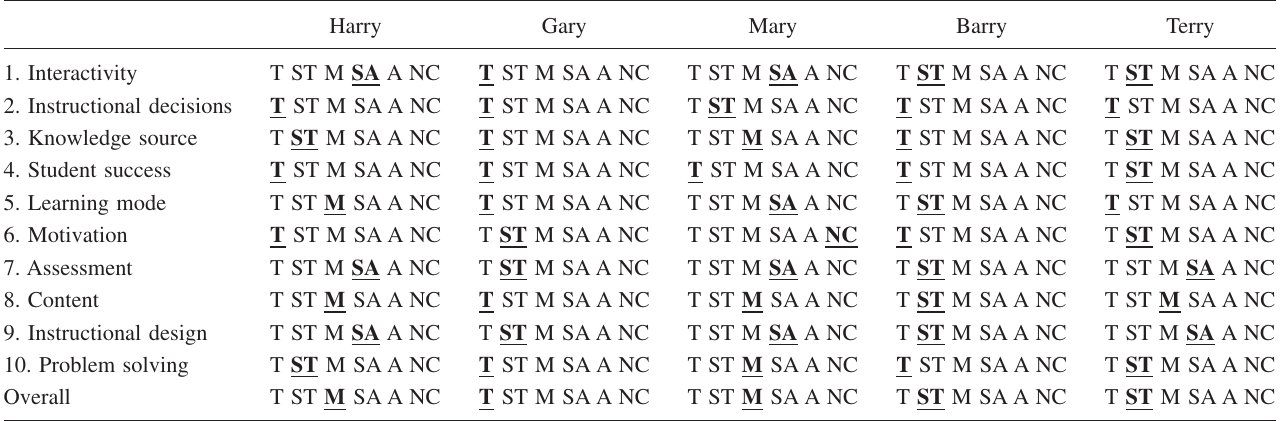
TABLE V. Rating of interviewees’ self-described instructional practices on main categories of